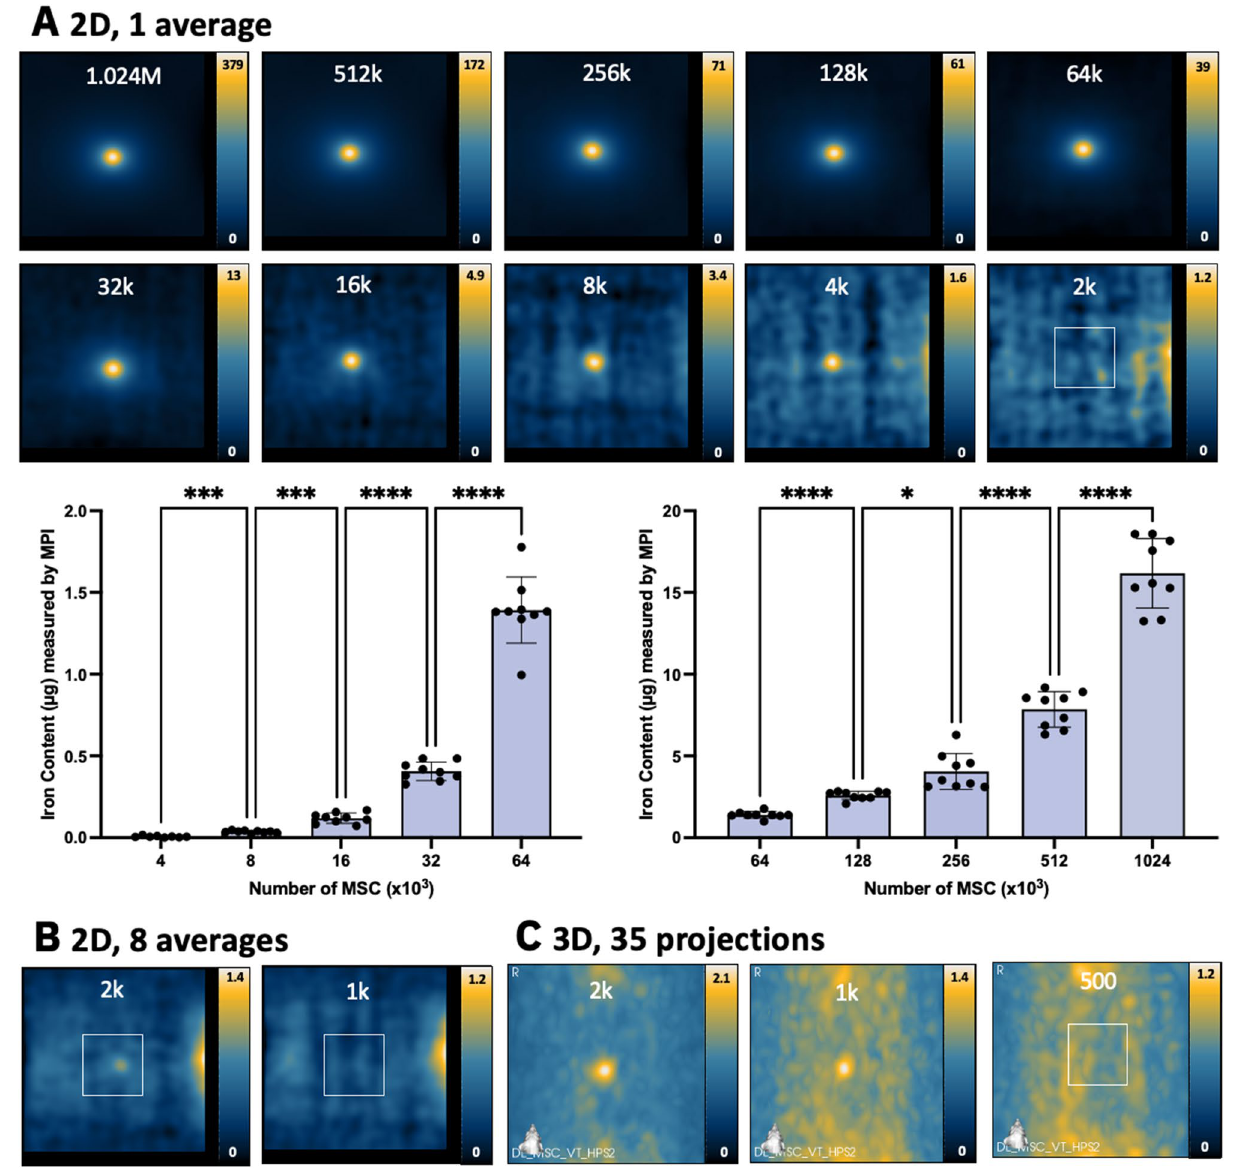
Figure 3. MPI detection of ferucarbotran-labeled MSC. ( A ) 2D MPI of individual MSC pellets containing the indicated cell numbers (M = 10 6 , k = 10 3 ). As few as 4000 MSC (0.076 μg ferucarbotran) could be detected with SNR > 5 in 1.5 min. 2D MPI signal (and the associated iron content) significantly increases with the number of MSC (* P < .05, ** P < .01, *** P < .001, **** P < .0001). ( B ) With 8 signal averages, the same result was found. ( C ) In 3D, the detection of 2000 cells (0.038 μg ferucarbotran, with SNR > 5) and 1000 cells (0.019 μg ferucarbotran, with SNR > 3) was possible in 23 min. Images with SNR < 5 have white boxes to indicate the placement of the cell